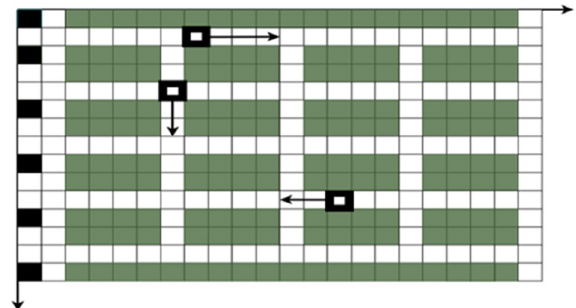
Figure 1. Plan layout of the four-way shuttle system studied in this